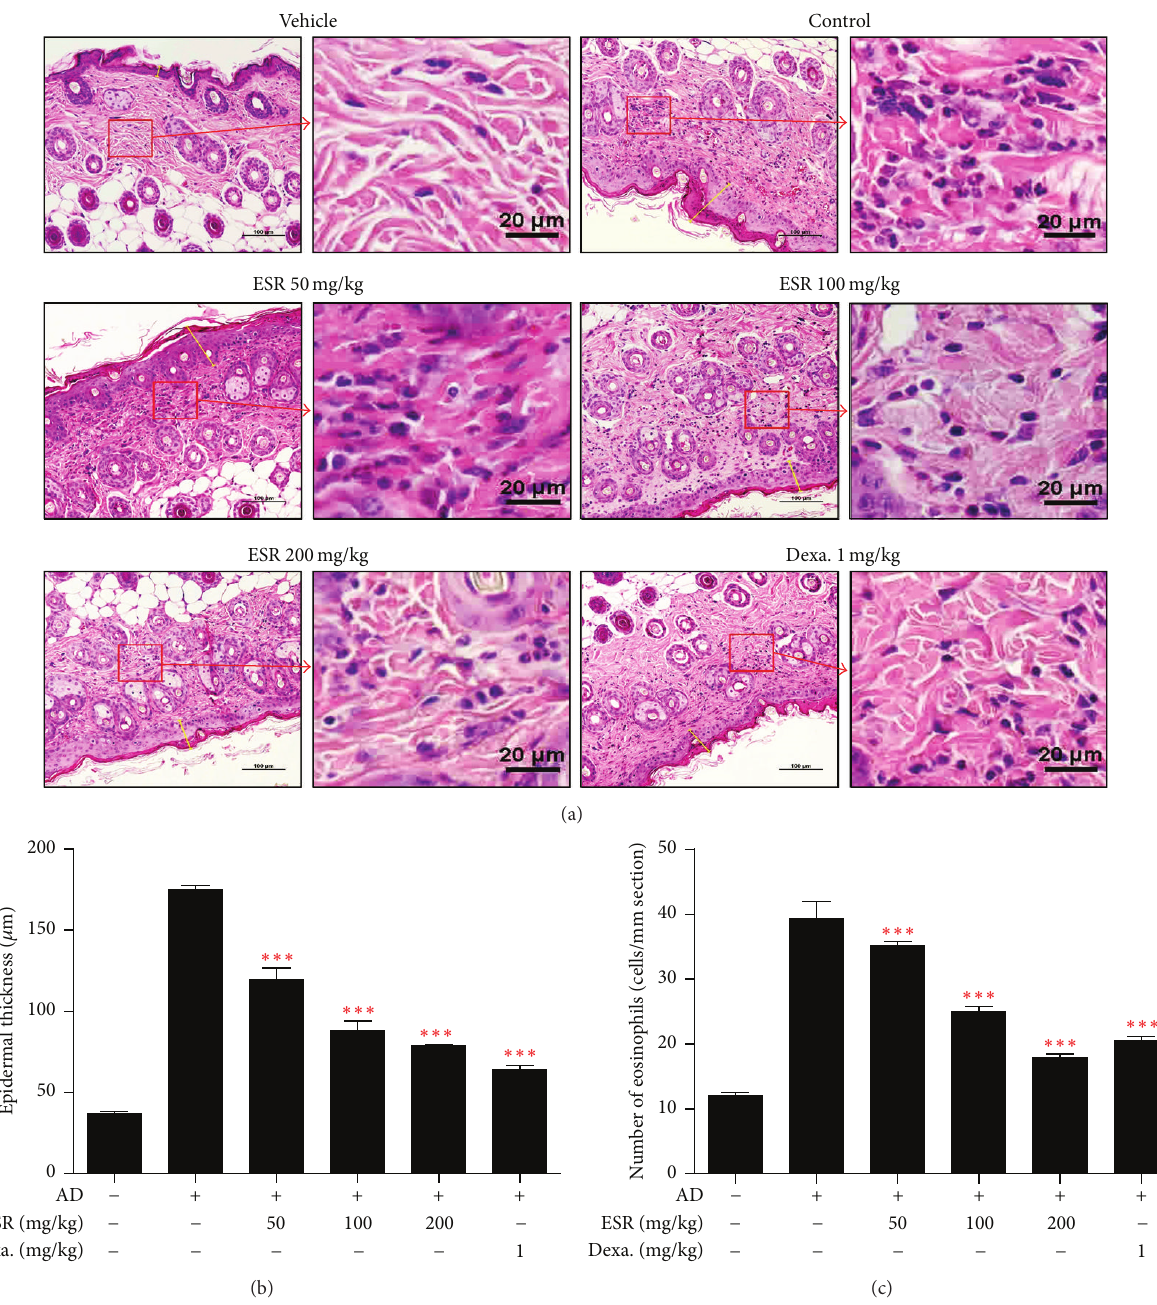
Figure 3: Effects of ESR on epidermal thickness and eosinophil accumulation in DNCB-induced AD mouse skin lesions. (a) H&E stained AD mouse skin lesions (20x, scale bar = 100 𝜇 m) and image of amplification sections (right image of group, scale bar = 20 𝜇 m). (b) Determination of epidermal thickness. (c) Number of eosinophils per mm section. Epidermal thickness in H&E stained sections was measured under a microscope and the number of eosinophils accumulations is expressed as the average total count in five fields of 100 𝜇 m 2 . ∗∗∗ 𝑝 < 0.001 versus